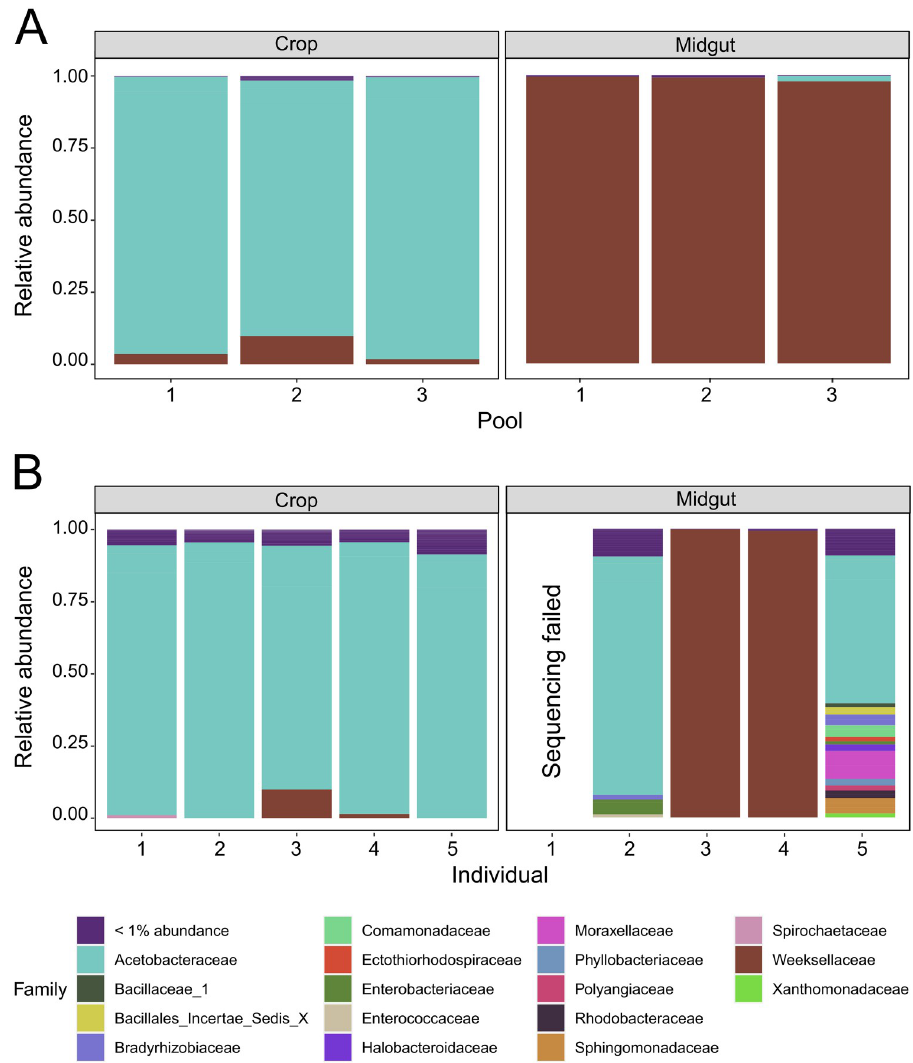
Fig 3. Composition of microbial communities in crops and midguts of Ae . aegypti adult females using a culture- independent approach. Relative abundances of bacterial families are clustered by tissue (labeled across the top) and sample type. In (A), samples are pooled in three groups of eight. Tissues from each numbered pool are paired, i.e., they were collected from the same eight individuals. In (B), samples are single (un-pooled) paired tissues, i.e. each numbered crop came from the same individual as the matching numbered midgut. Bacterial communities in crops are dominated by Acetobacteraceae. Midguts are mostly dominated by Weeksellaceae, though individual midgut samples 2 and 5 lack Weeksellaceae and are dominated by